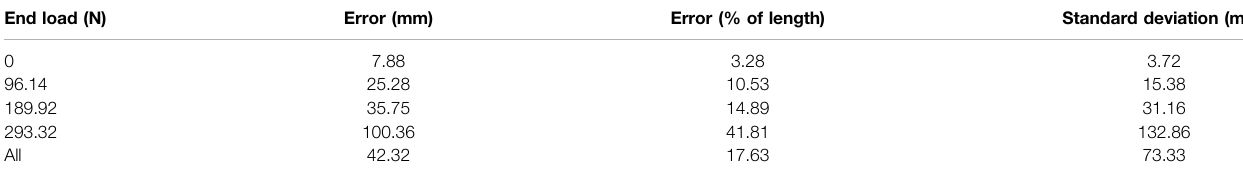
TABLE 3 | Mean positional tip location error together with the standard deviation for increasing end